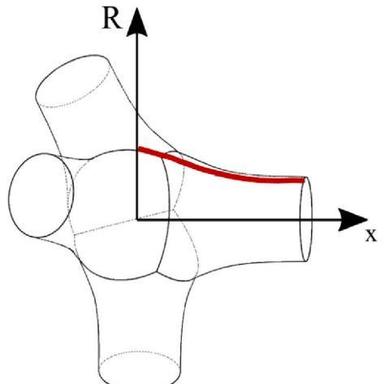
Actual ligament profile of open-cell foams.